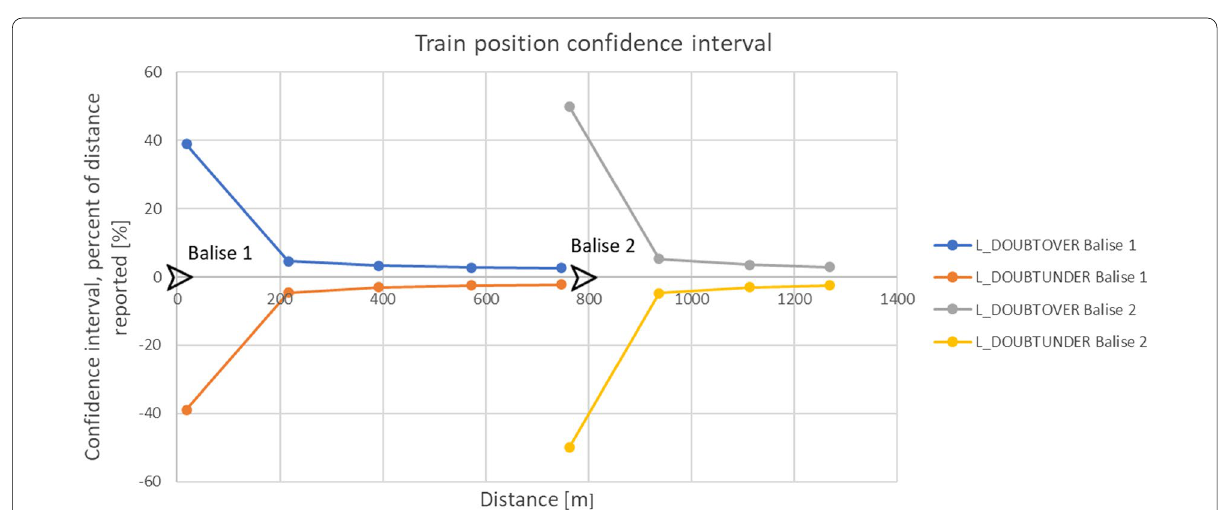
Fig. 7 Example of train position confidence interval. The train passes two balises and sends 9 TPRs during these 1300